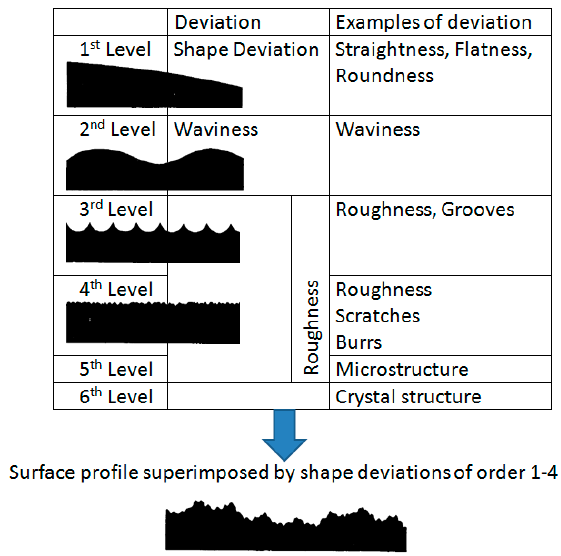
Figure 7. Classification of deviations acc. to DIN 4760 [27].